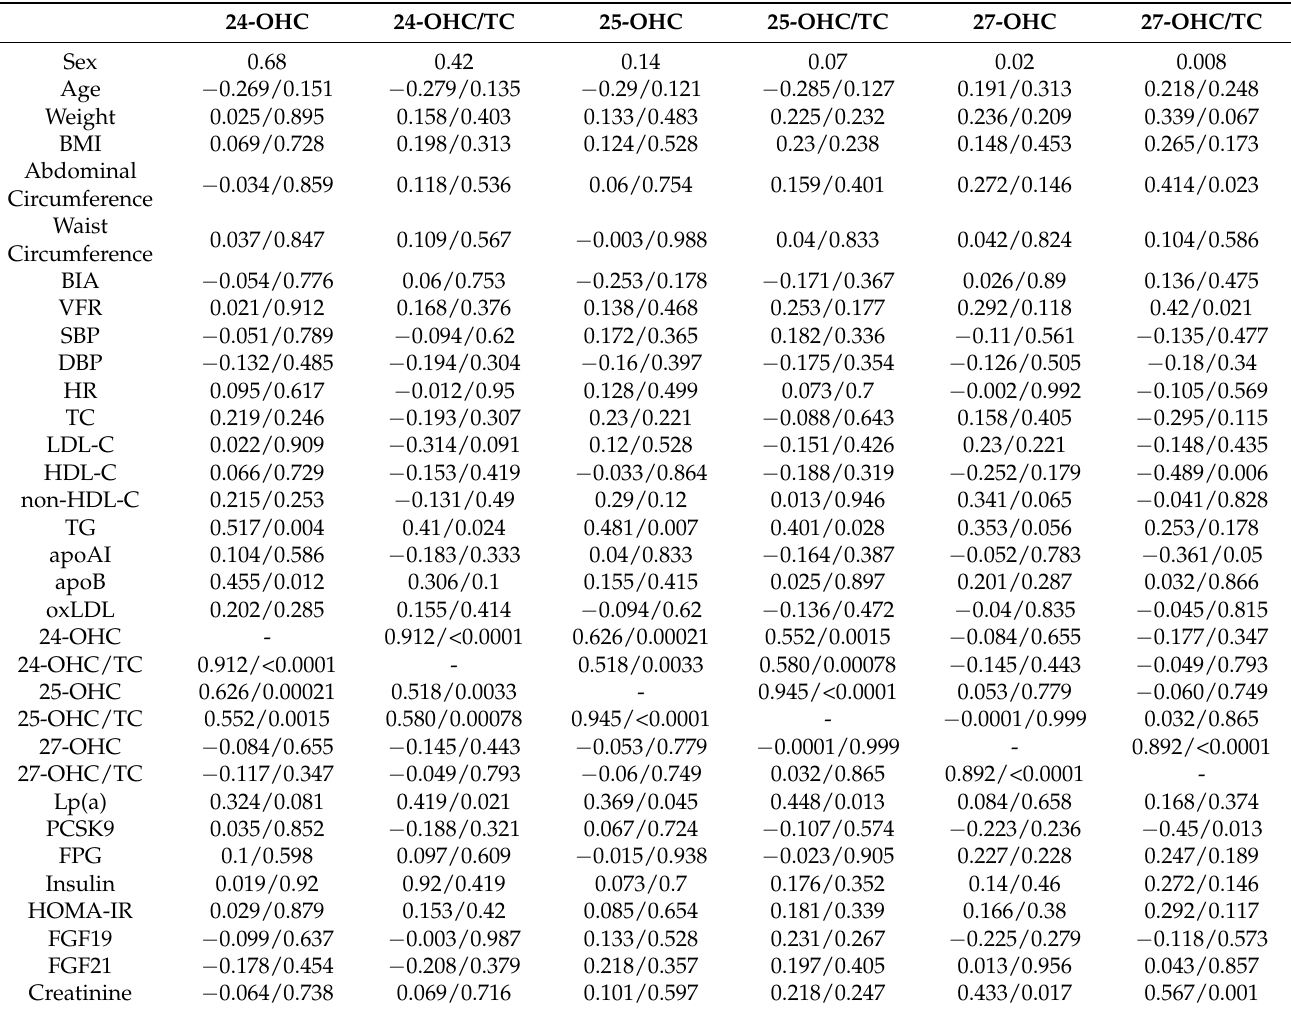
Table 2. Correlation of circulating oxysterols levels and total cholesterol-normalized circulating oxysterols levels with clinical and biochemical characteristics of the study population.